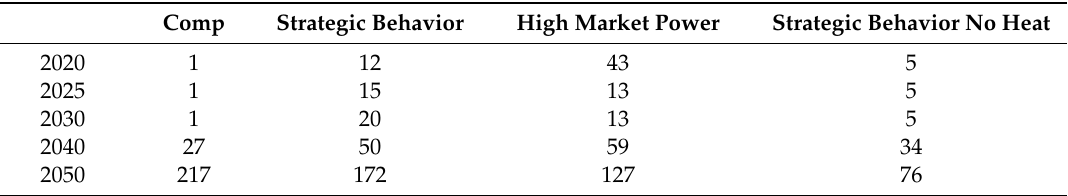
Table 2. Developments of CO 2